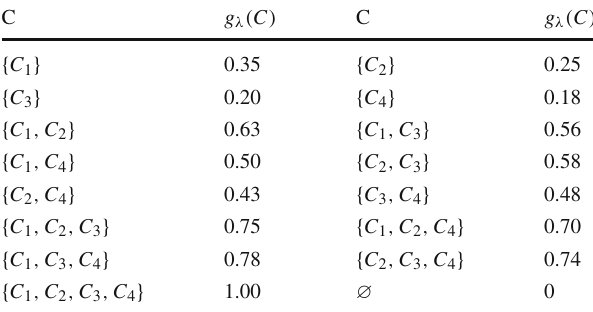
Table 1 The fuzzy measures of criteria